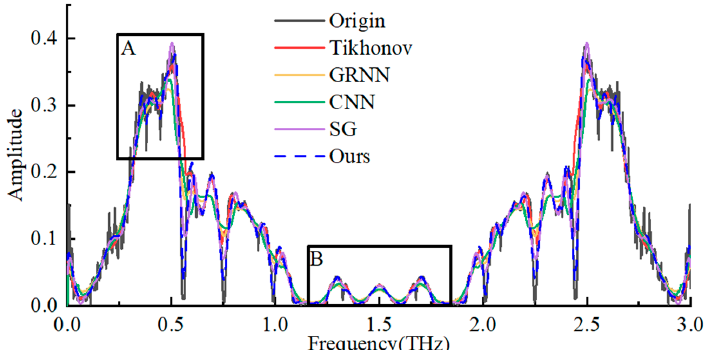
Figure 8. The real THz spectrum experiment. Region A and B are enlarged in Figures 9 and 10.